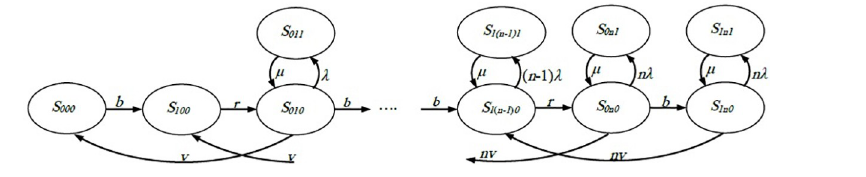
Fig 4. State transition diagram of n-machine